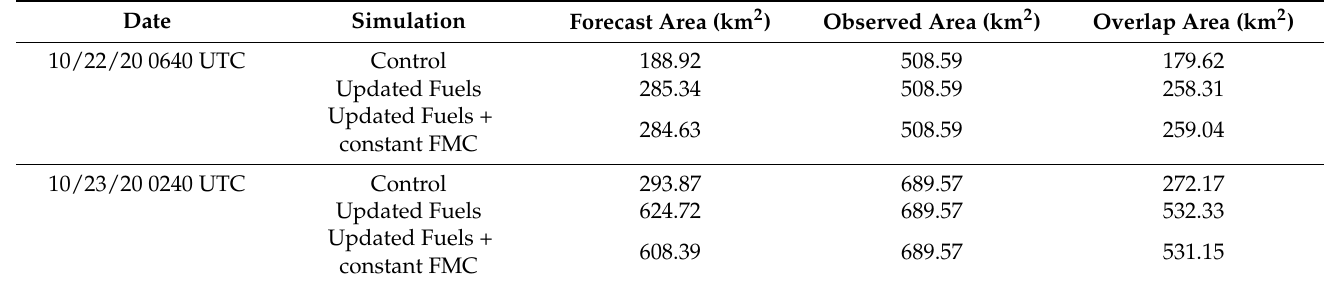
Figure 6. Time series of ( a ) burn area (km 2 ), ( b ) burn area fraction (ratio of ML to Control), ( c ) burn rate (km 2 h − 1 ), and ( d ) burn rate difference (ML minus Control). Model results are shown by the lines (according to the legend), while NIFC IR perimeters are shown in the magenta diamonds (labeled ‘Obs’ in the legend). The legend for panel ( a ) also applies to panel ( c ). Table 3. Summary of the forecast burned area values, compared with observations occurring at the two timestamps within the simulation time frame. All forecast values in the table result from the simulations using NAM meteorological